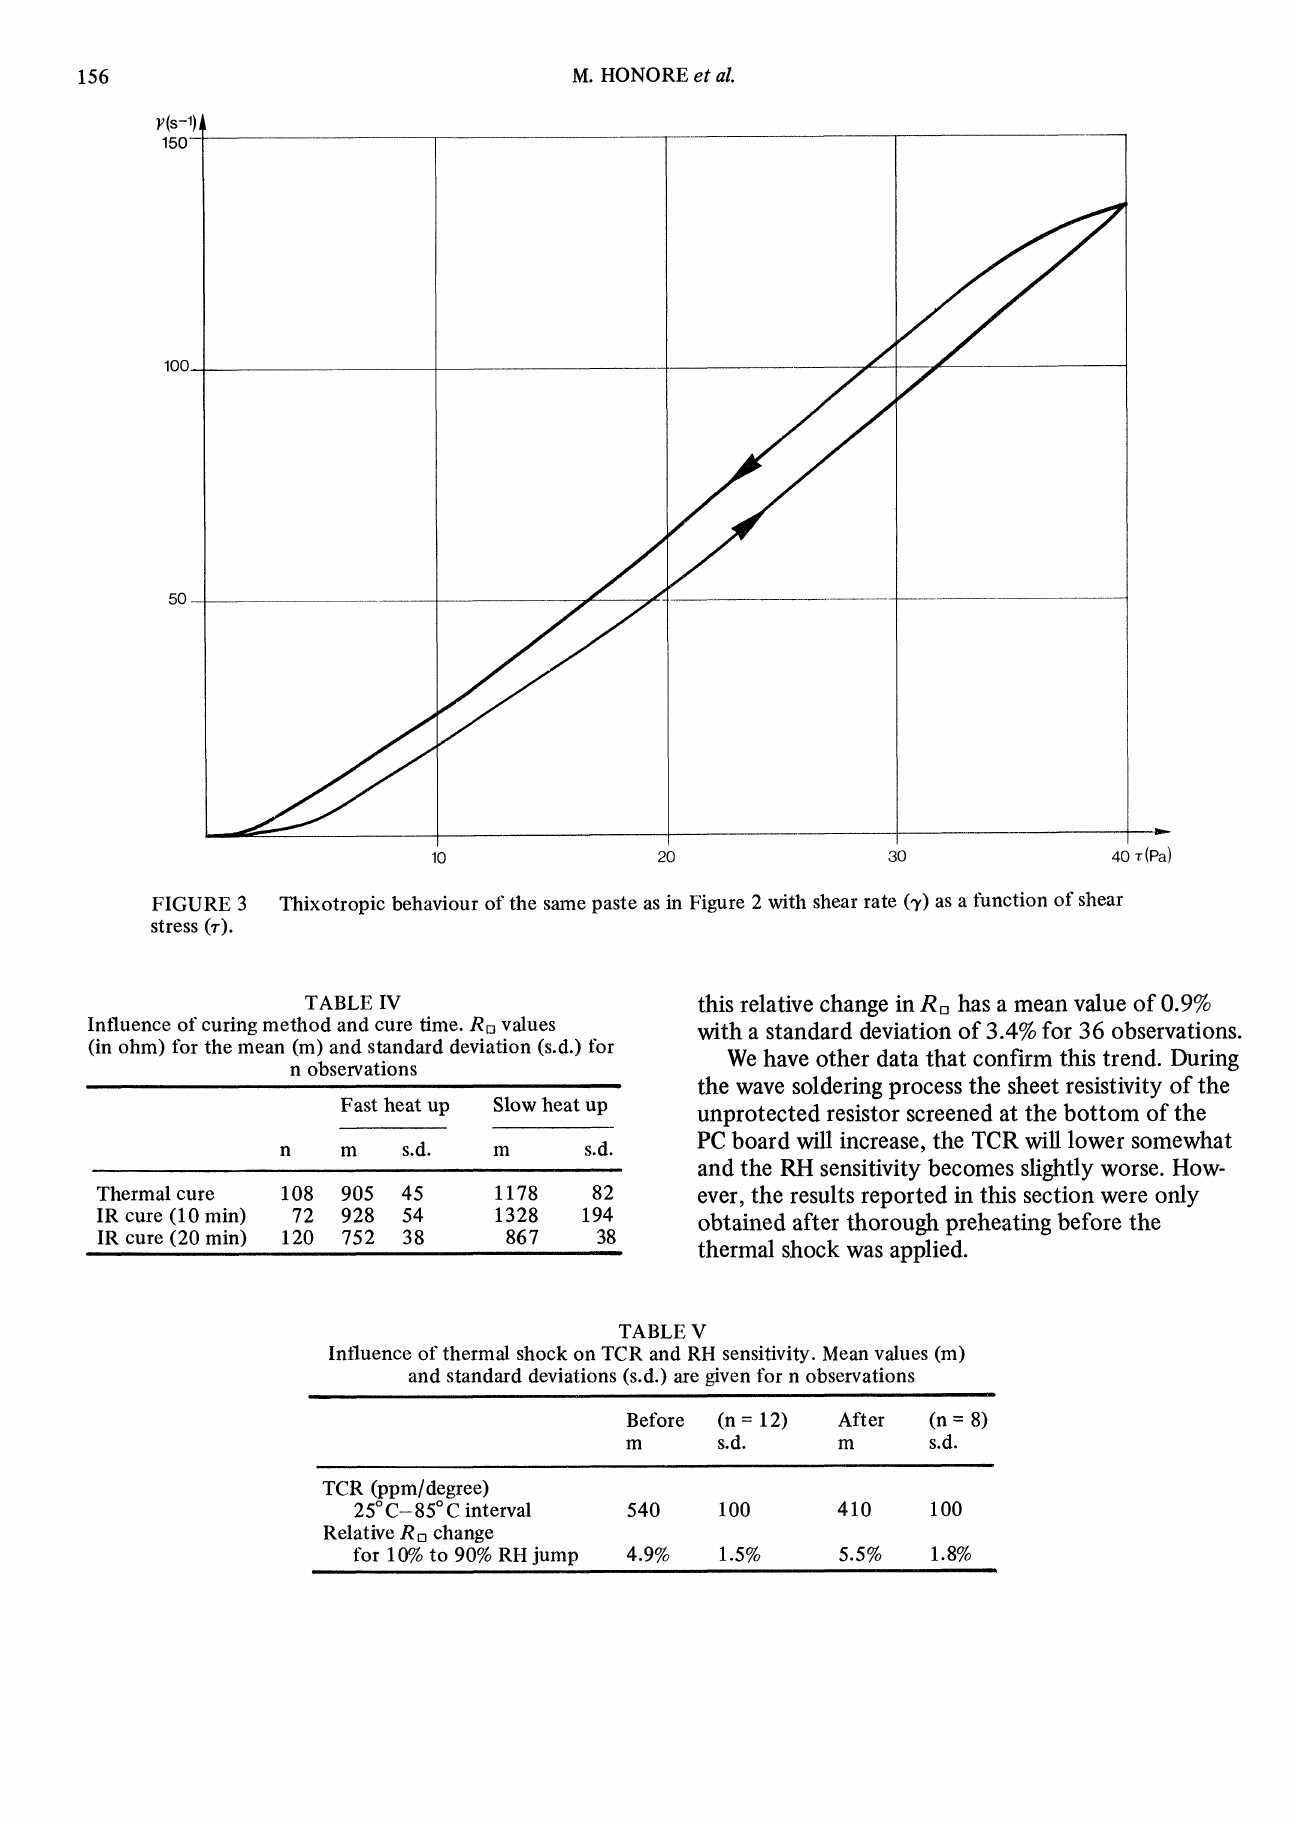
TABLE V Influence of thermal shock on TCR and RH sensitivity. Mean values